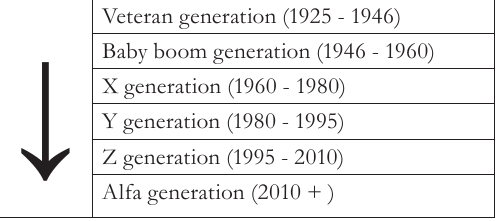
Fig. 1 – Time-line of generations. Source: authors’ construction (on the basis of Zemke et al.,